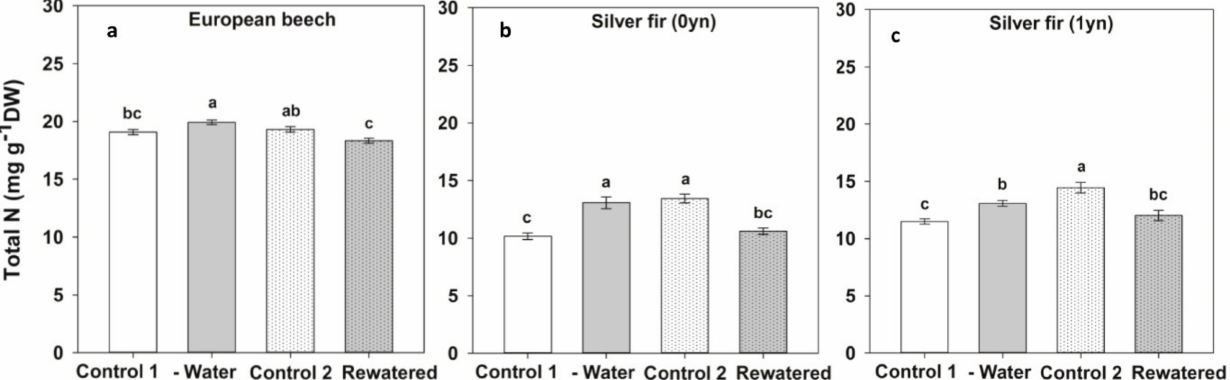
Figure 5. Foliar total N contents of beech ( F. sylvatica L.) ( a ) and silver fir ( A. alba Mill.) ( b , c ) seedlings. 0yn, current − year needles; 1yn, one − year needles. Significant differences between controls and